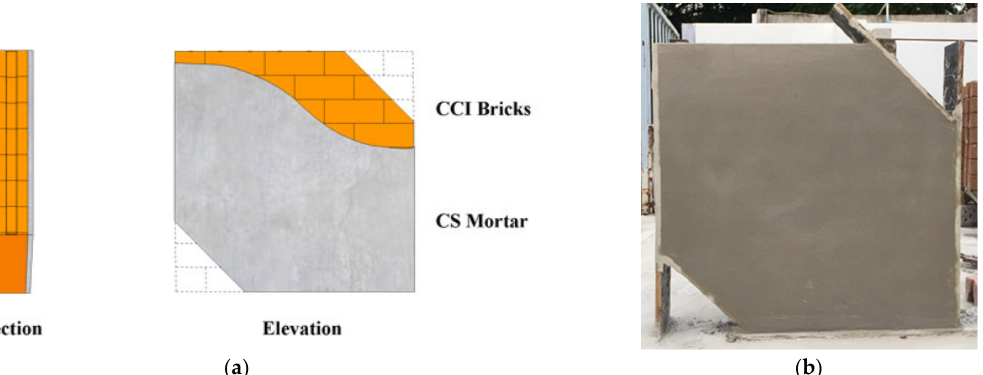
Figure 3. Application of epoxy resin and CFRP: ( a ) Epoxy resin applied to the wall; ( b ) Hand layup method of CFRP application; ( c ) Unidirectional CFRP.